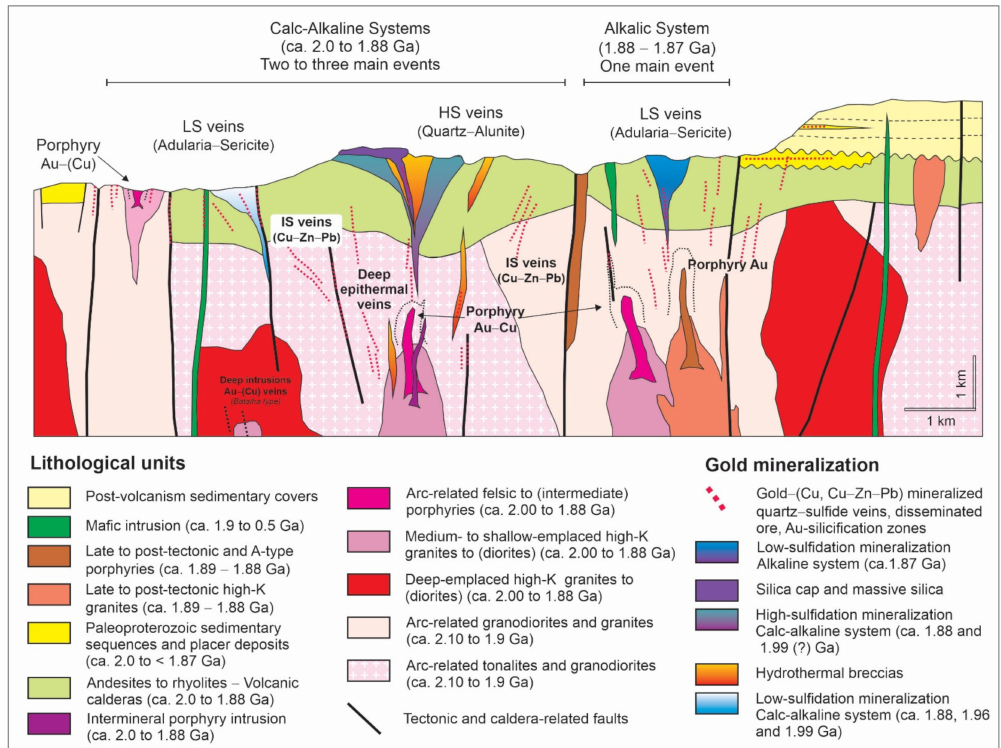
Figure 9. A conceptual model for the gold deposits in the TMP. At the JMP, gold deposits were formed in younger episodes than those of the TMP, but as part of a similar magmatic–hydrothermal